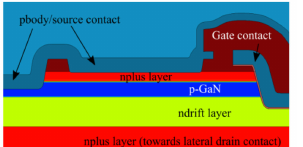
Figure 10. Simulated structure representing the GaN trench MOSFET